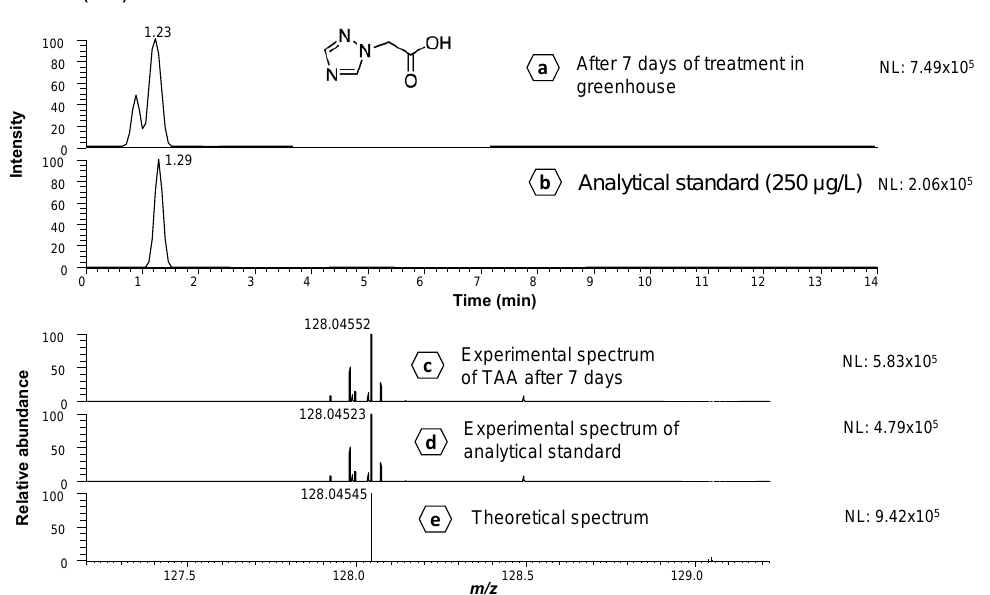
Figure 4. Extracted ion chromatograms of triazole acetic acid (TAA): ( a ) after 7 days of treatment in greenhouse; ( b ) analytical standard (at 250 µ g/L); ( c ) full-scan MS experimental spectrum of TA after 7 days of treatment in greenhouse; ( d ) full-scan MS experimental spectrum of analytical standard; and ( e ) full-scan MS theoretical spectrum.